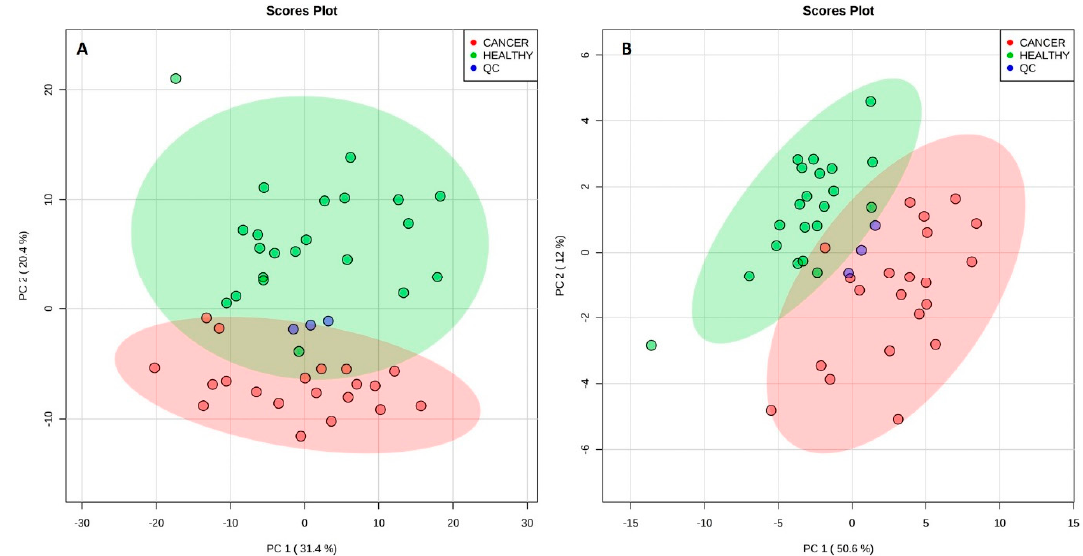
Figure 3. Principal component analysis (PCA) scores plot for plasma analysis in positive ion mode ( A ) and in negative ion mode ( B ). Segregation was observed for both modes between cancer and healthy individuals. Quality control (QC) samples (pool of all the samples) are also plotted. The explained amount of the total variance of the full data set is shown for each principal component (PC1 ‐ 2).